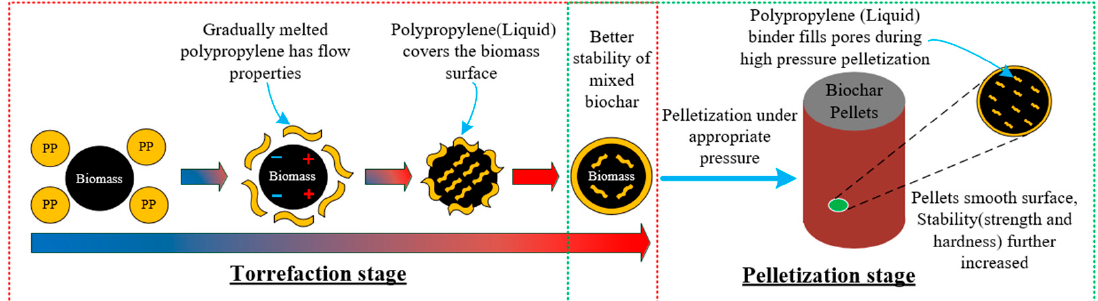
Figure 9. Principle of biochar pelletization using PP as a binder at different stages.